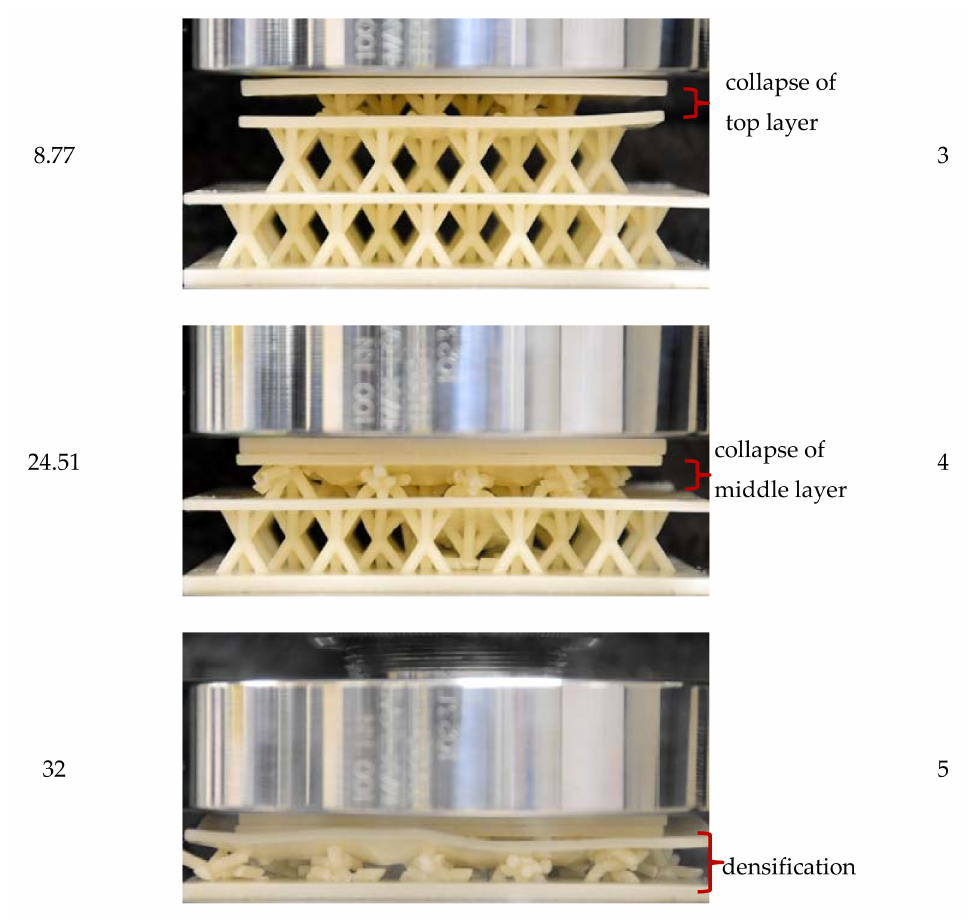
Figure 8. Deformation of a uniform density Kagome at different displacement during the compression test.